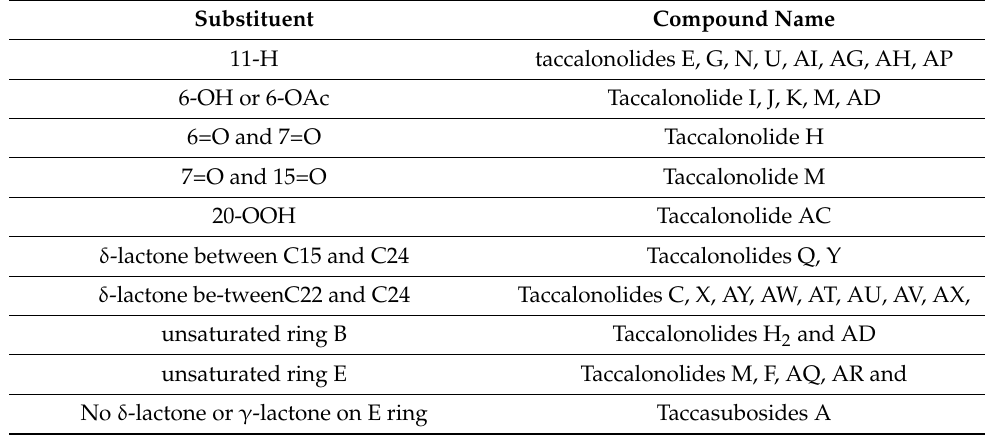
Figure 3. The Structures of taccalonolides O and P, the basic structure of perulactones, and an overview of withanolide biosynthesis. Table 2. Selective natural taccalonolides with rare substructures or